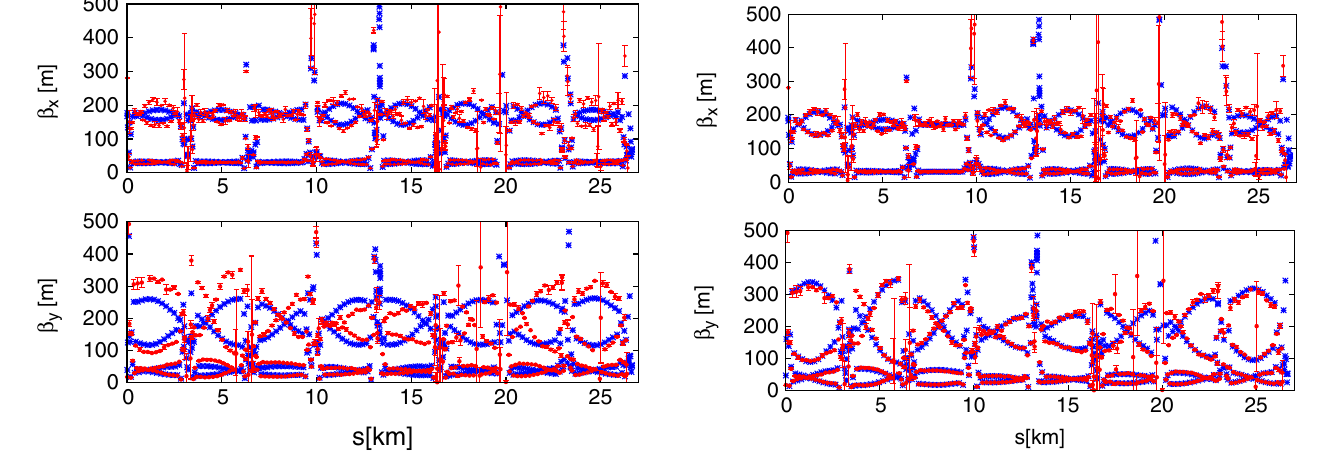
FIG. 7. (Color) Comparison of measured beta functions (red) and the model (blue) after including all the findings from the segment by segment.